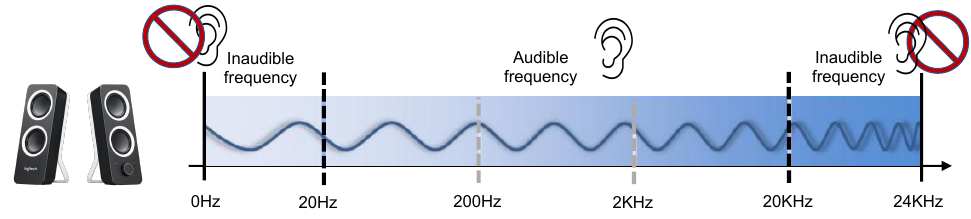
Figure 11. Audible and inaudible frequency bands produced by PC speakers.